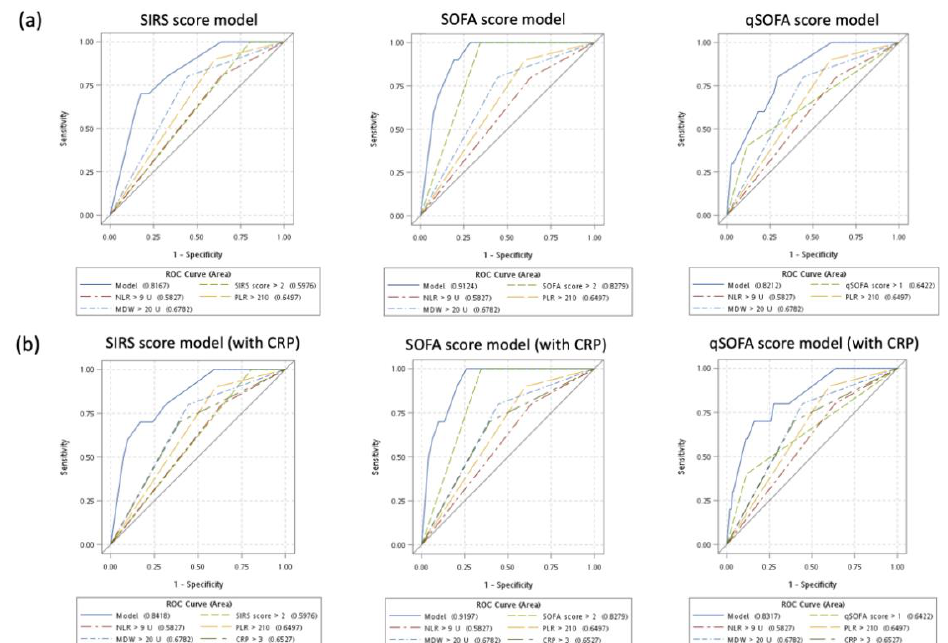
Figure 3. Receiver of operating characteristic (ROC) curves of predicting mortality for models based on SIRS score, SOFA score, and qSOFA score. ( a ) Models without CRP. ( b ) Models with CRP.